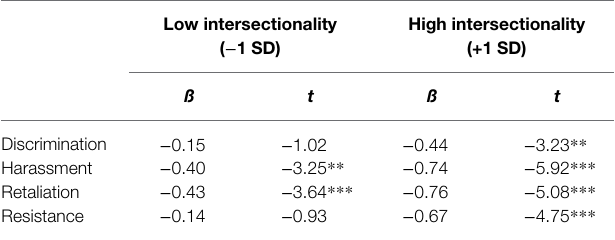
TABLE 3 | Simple slopes analysis for different levels of